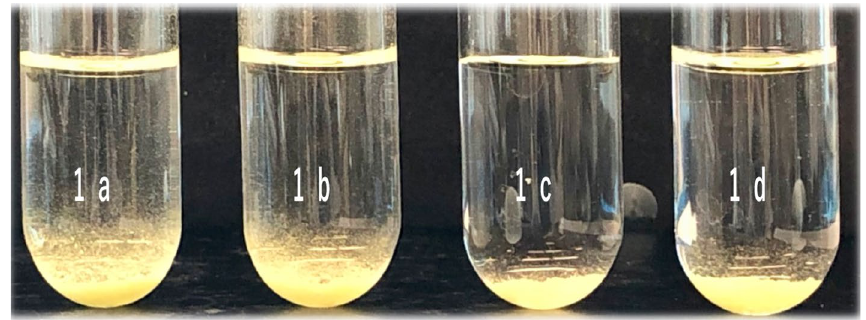
Fig. 2 Reaction mixtures after the iodoform test using 1a–d conducted in